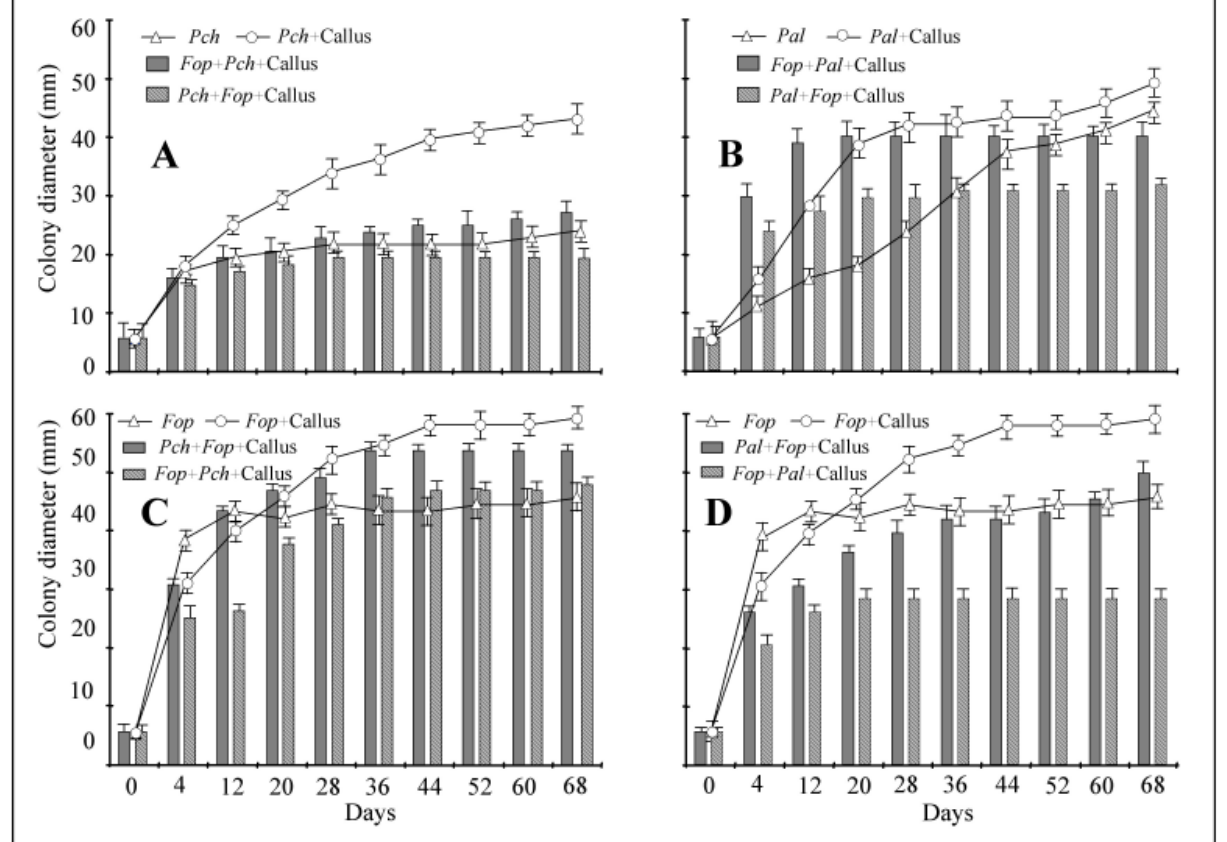
Fig. 1. Comparison of growth rates of: A. Phaeomoniella chlamydospora ( Pch ); B. Phaeoacremonium aleophilum ( Pal ); C. and D. Fomitiporia punctata ( Fop ) grown singly or in dual culture with cv. Italia callus. Standard error bars are